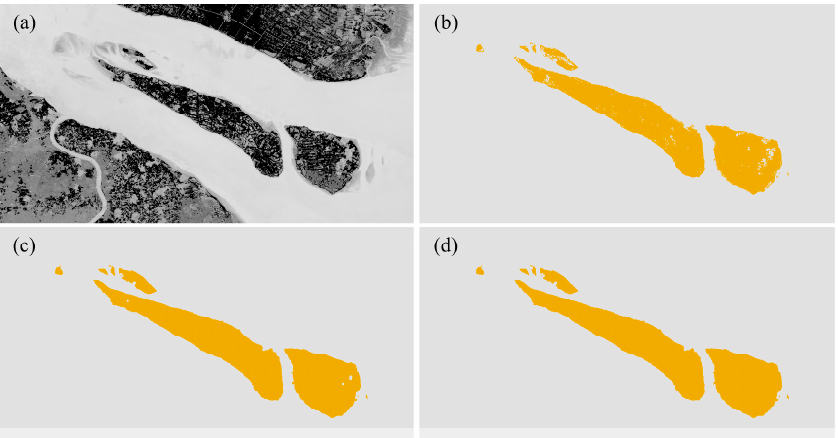
Figure 4. An example of generating an annual map of the estuarine islands in 1990. ( a ) The MNDWI image from 1990; ( b ) Land-water classification map after the thresholding segmentation; ( c ) Land-water classification map after the closing operation; ( d ) Land-water classification map after the filling operation (i.e., the final results); In ( b – d ), the yellow area represents the estuarine islands. In a, the light area represents the water body, and the dark area represents the land area.